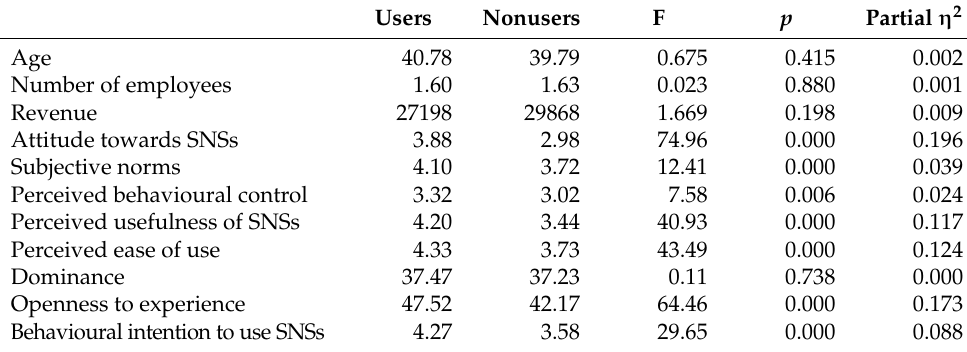
Table 1. Differences in the main variables of this study between users and